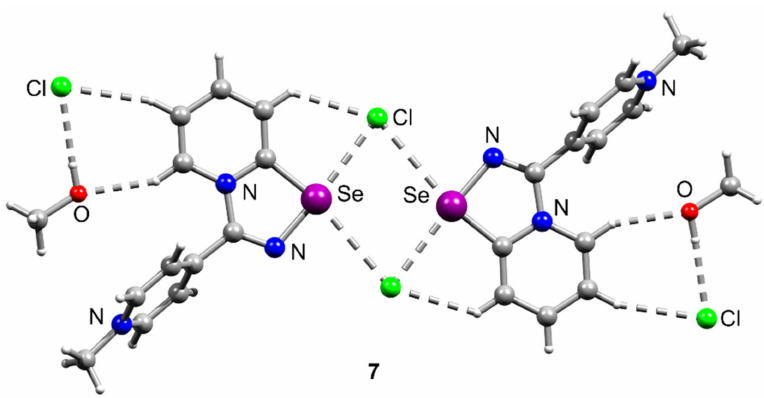
Figure 7. Ball-and-stick representation of the crystal structure of 7 , demonstrating attractive Se ··· Cl, H ··· Cl, and H ··· O interactions. Grey and light-grey spheres represent carbon and hydrogen, respectively.